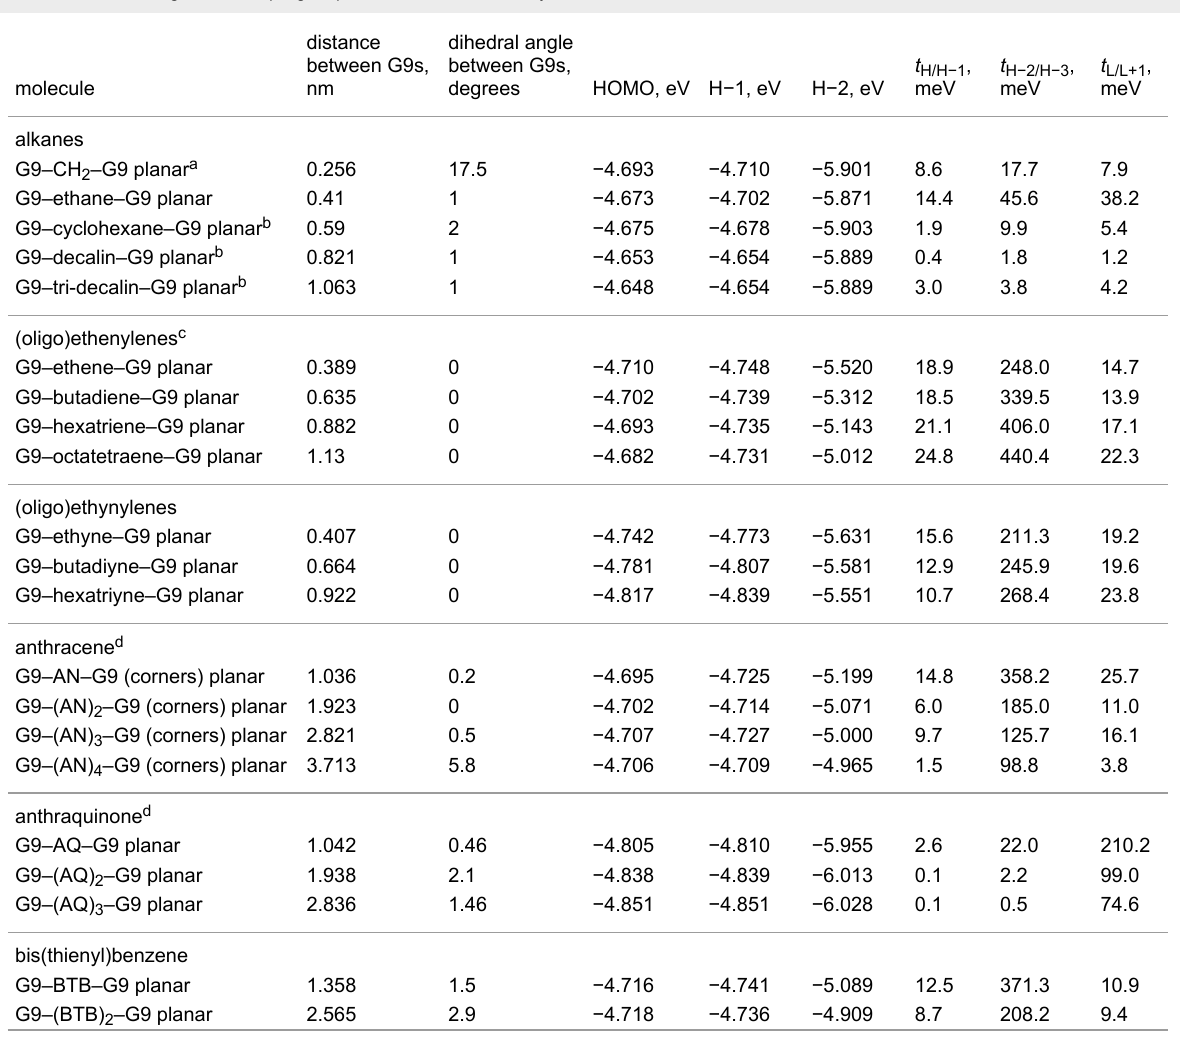
Table 4: Orbital energies and coupling for planar G9–molecule–G9